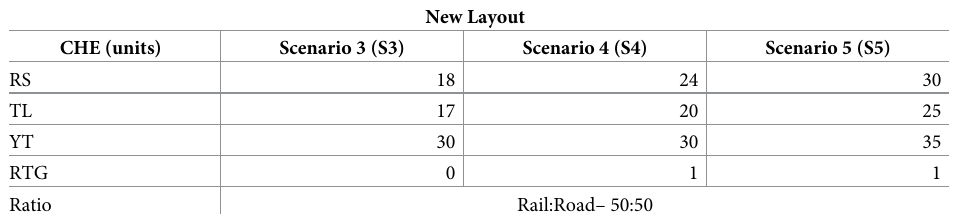
Table 3. Settings for scenarios S3–S5 (the new LICD layout).